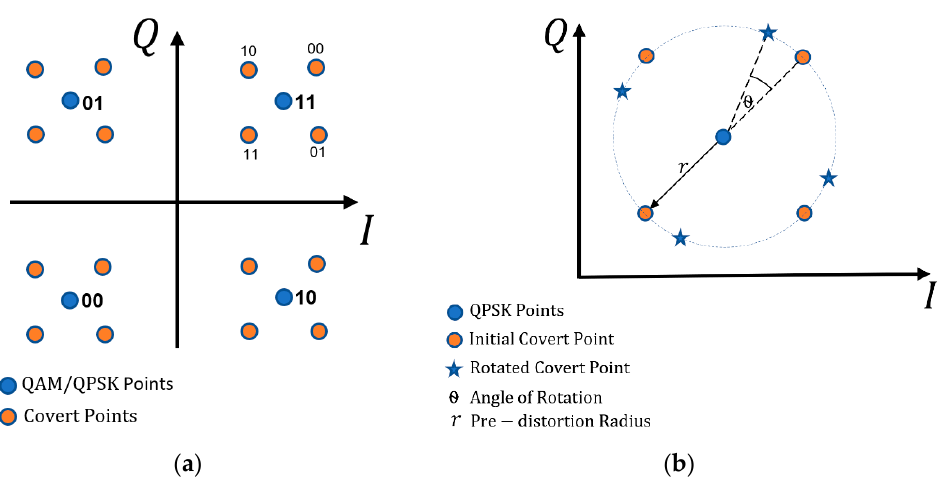
Figure 1. Dirty constellation: ( a ) assigning bits to constellation points; ( b ) chosen constellation point.